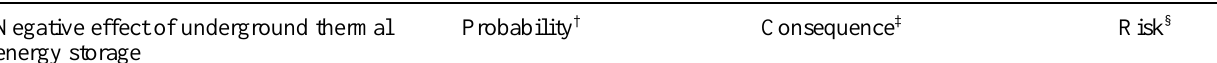
Table 1. Qualitative overview of risks of low-temperature (< 30°C) underground thermal energy storage on groundwater